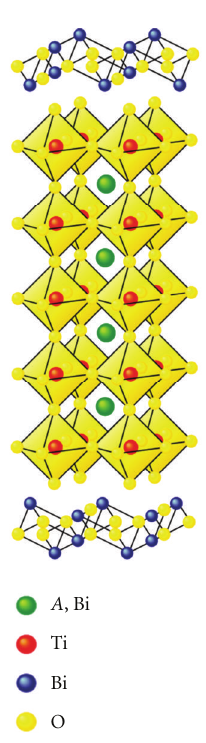
The square of soft mode frequency decreases toward the highest phase transition temperature (850 K) and shows a clear anomaly at 610 K ( T c ). The soft mode exists in the ferroelectric phase and shows highly overdamped behavior near T c , although dielectric constant does not diverse at T c . Another anomaly was detected in the share strain c 44 at 850 K [46], which corresponds to the high-temperature phase transition at 850 K.